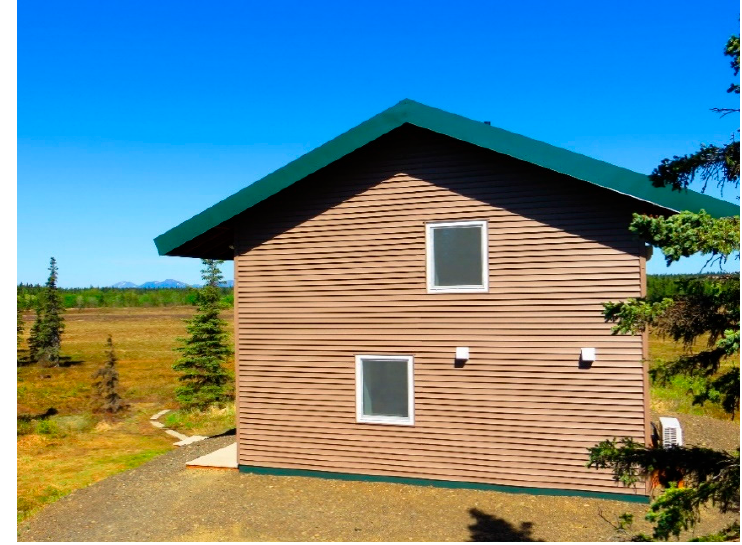
Figure 1. Photograph of the case study house from the outside.